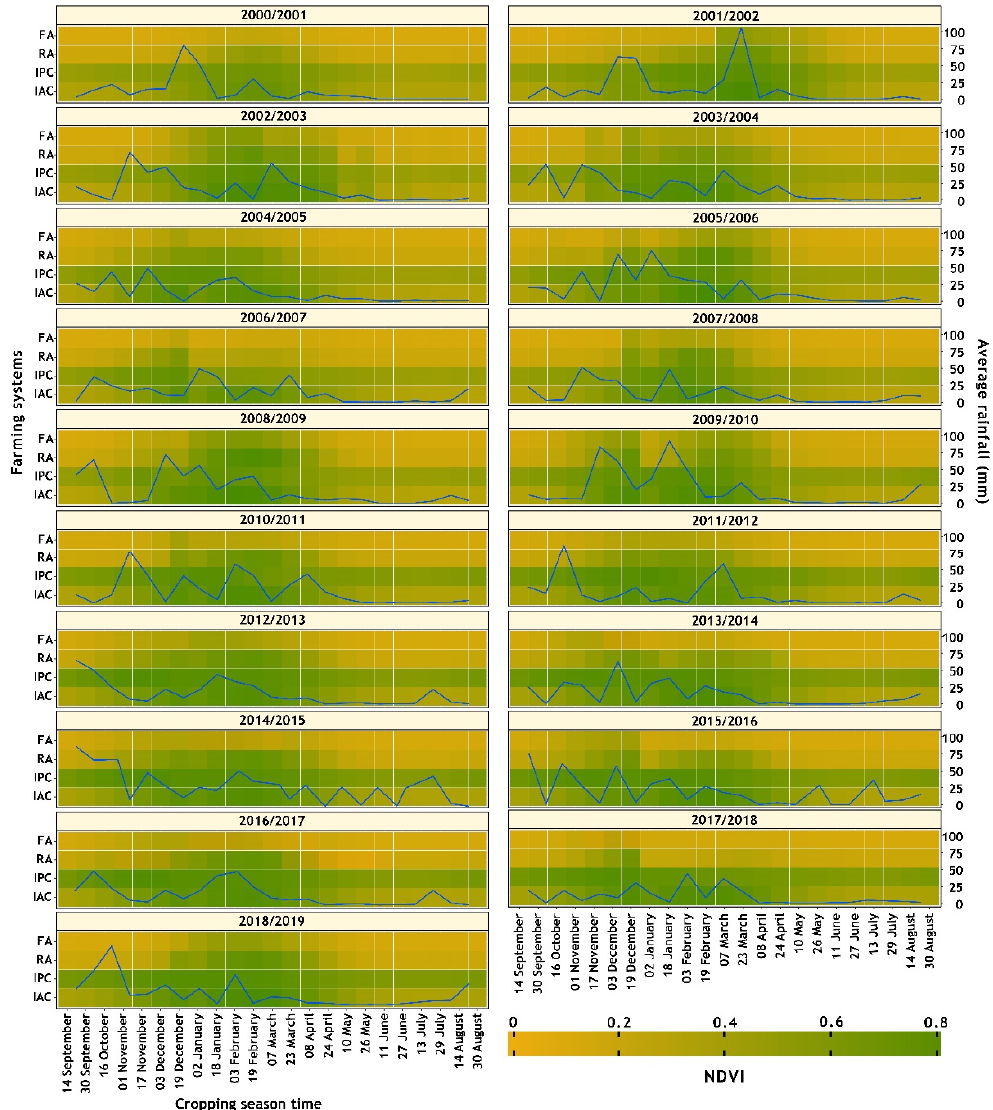
Figure 5. NDVI variability over the four farming systems over the Oum Er-Rbia (OER) basin between 2000 and 2019. NDVI presents the average values extracted from reference data; rainfall data were retrieved from Climate Hazards group Infrared Precipitation with Stations (CHIRPS) [44] over the OER basin.